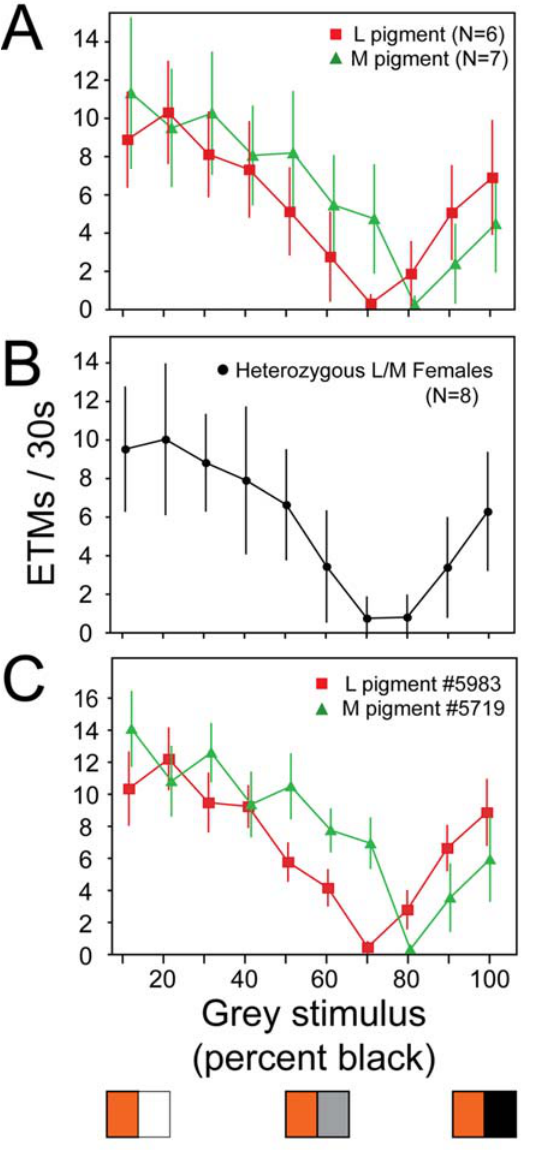
Figure 4. Chromatic sensitivity of the OKR in mice with different cone photopigments. (A) Number of ETMs (mean + / 2 standard deviation) per 30-second interval for each of ten stimuli consisting of alternating orange and grey vertical stripes, with each stripe subtending 4 u . The image was rotated at 5 u per second. For the ten different stimuli, the orange intensity was held constant and the grey intensity was varied in 10% intensity steps from white (stimulus 1) to black (stimulus 10) as shown by the three representative panels at the bottom of the figure. The responses are from seven Gnat1 2 / 2 ;M pigment mice and six Gnat1 2 / 2 ;L pigment mice. Each point represents 9–20 30-second stimulus intervals per condition. The interpolated grey intensity that yields the fewest ETMs per 30 seconds provides the best estimate of the psychophysical null point. (B) As for panel (A) but averaged data from eight Gnat1 2 / 2 ;M pigment/L pigment heterozygous female mice. (C) As for panel (A), but the responses are from a single Gnat1 2 / 2 ;M pigment mouse and a single Gnat1 2 / 2 ;L pigment